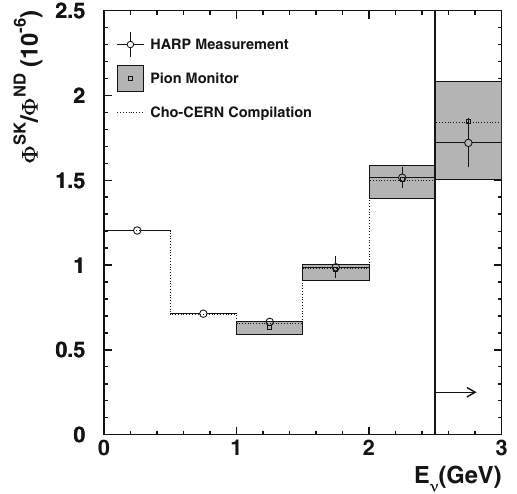
Fig. 20 Prediction for the K2K muon neutrino far-to-near flux ratio in absence of oscillations. The empty circles with error bars show the central values and systematic errors on the muon neutrino flux predic- tionsfromtheHARP π + productionmeasurementdiscussedinthetext, the empty squares with shaded error boxes show the central values and errors from the pion monitor measurement, and the dotted histograms show the central values from the Cho-CERN compilation of older (non- HARP) π + production data